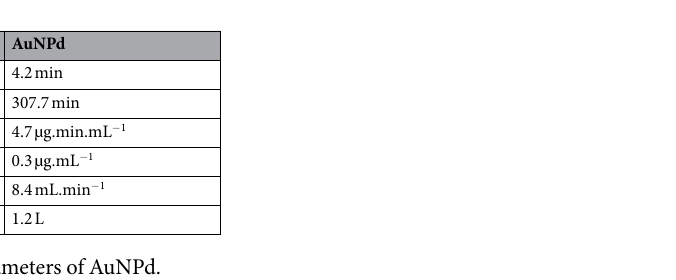
Table 1. Pharmacokinetic parameters of